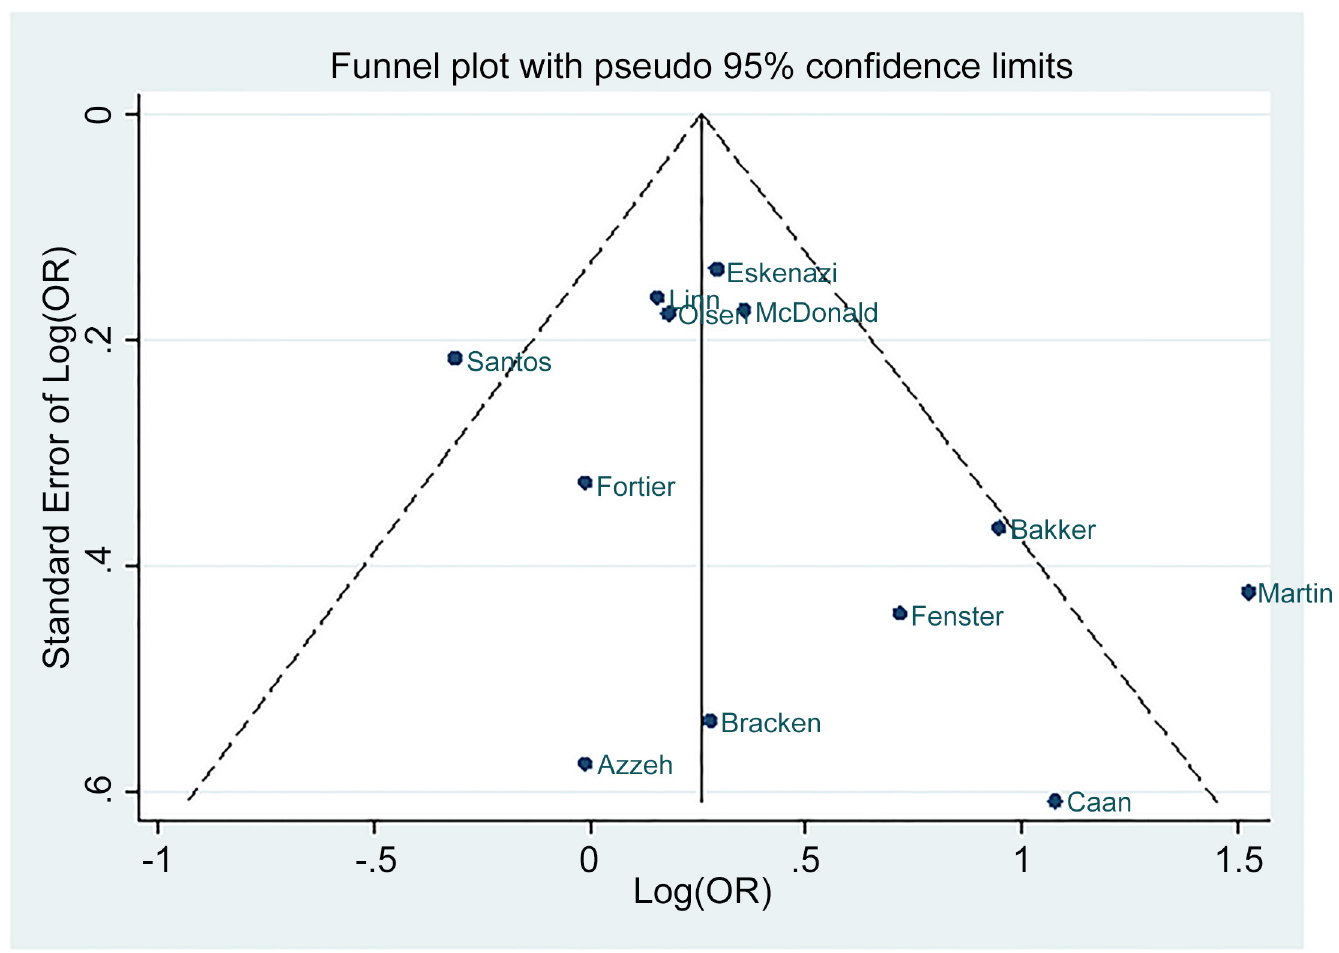
Fig 6. Funnel plot of meta-analysis on the effect of caffeine intake during pregnancy on low birth weight.